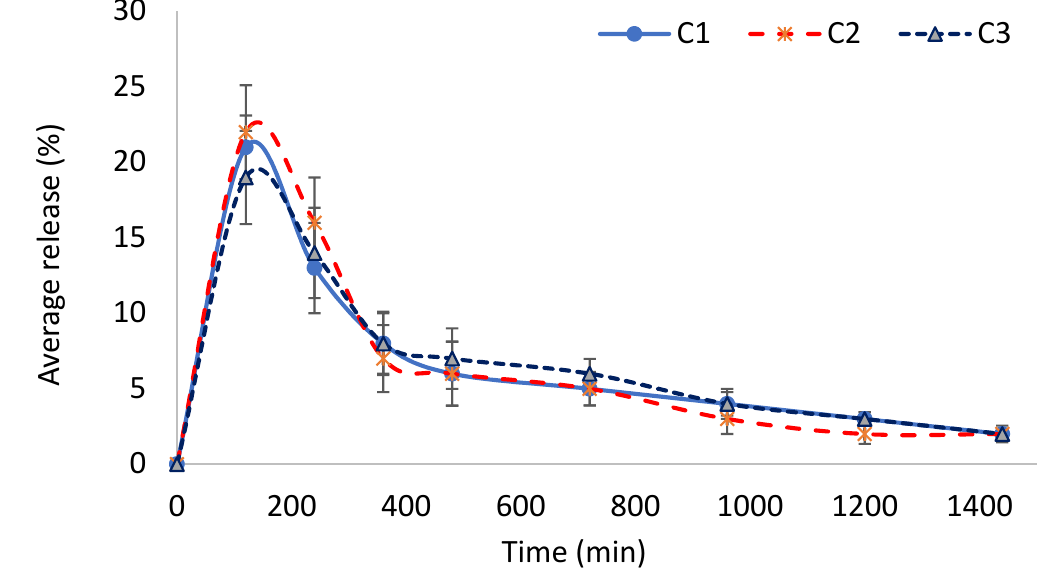
Figure 12. Effect of GA on the release profile of 5-FU at pH 1.2.